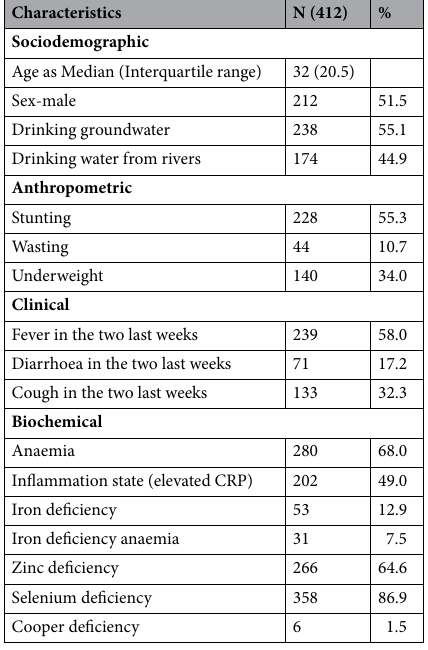
Table 1. General characteristics of the study participants in